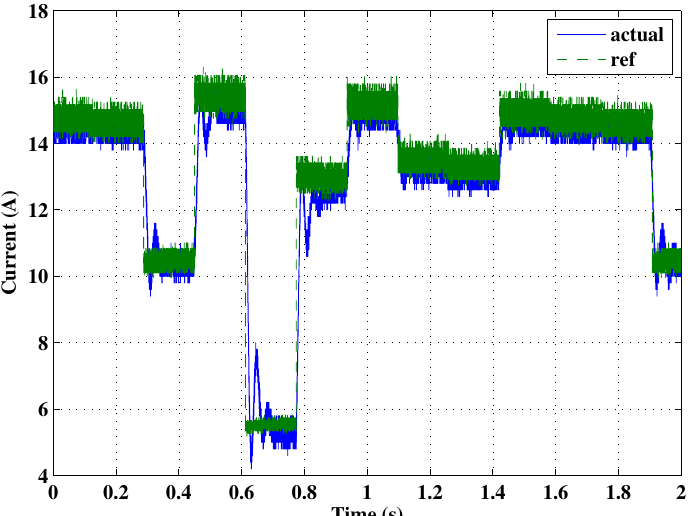
Figure 16. Reference and actual current supplied by solar resource using optimal high dimension droop